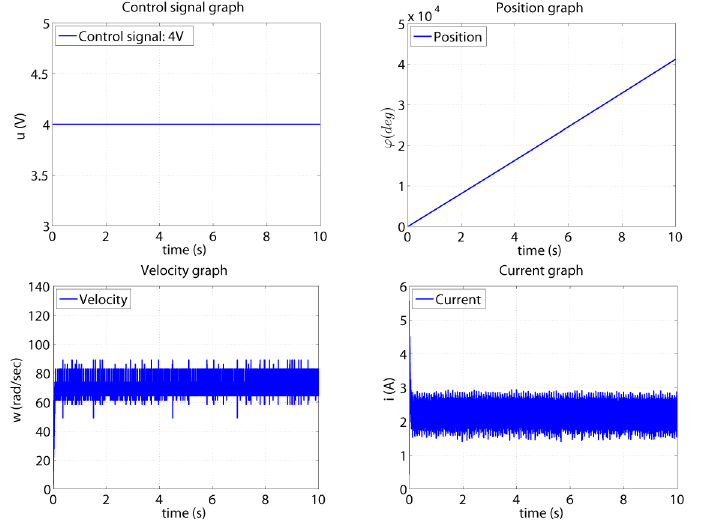
Fig 4. Collected measurements for u = 4V.